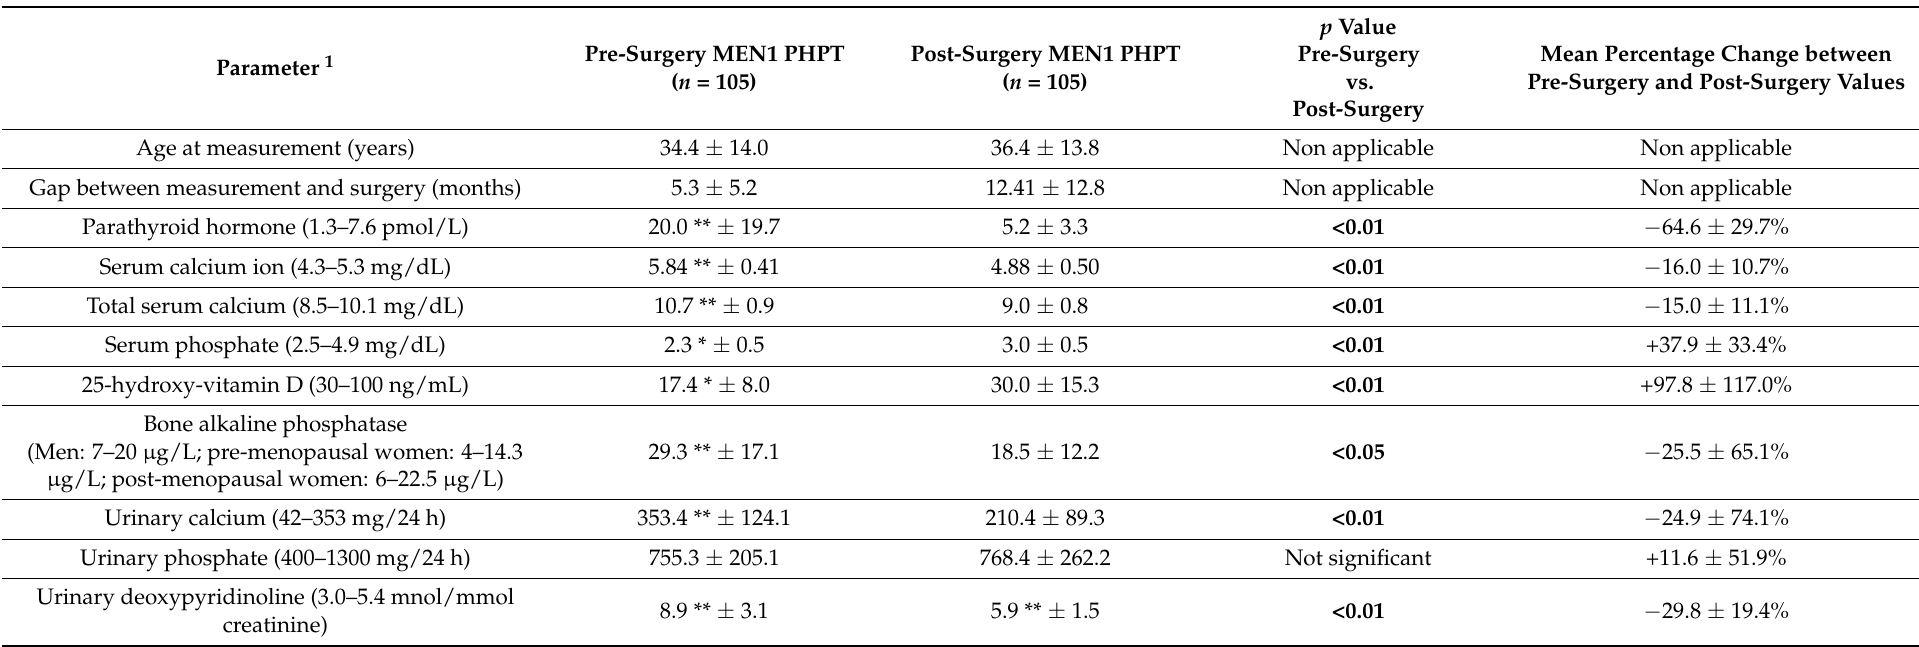
Table 2. Comparison of serum and urinary bone and mineral metabolism-related parameters, measured before and after PTX, in MEN1 PHPT